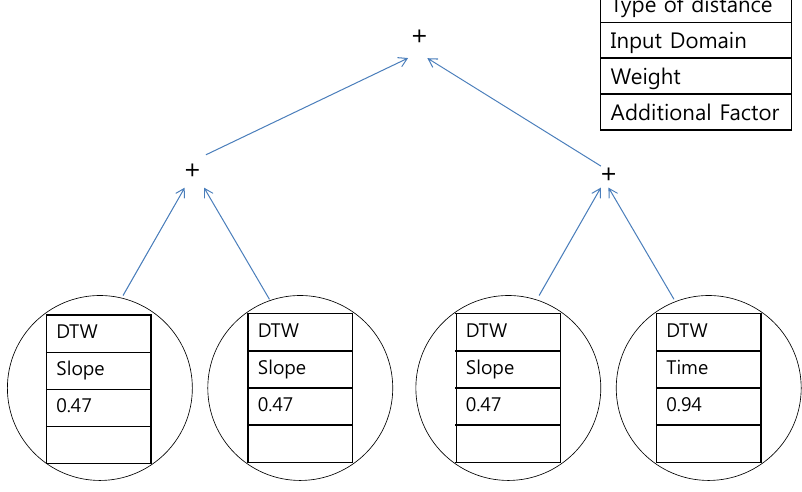
Figure 16. Proposed tree for the southern region using the data of expert